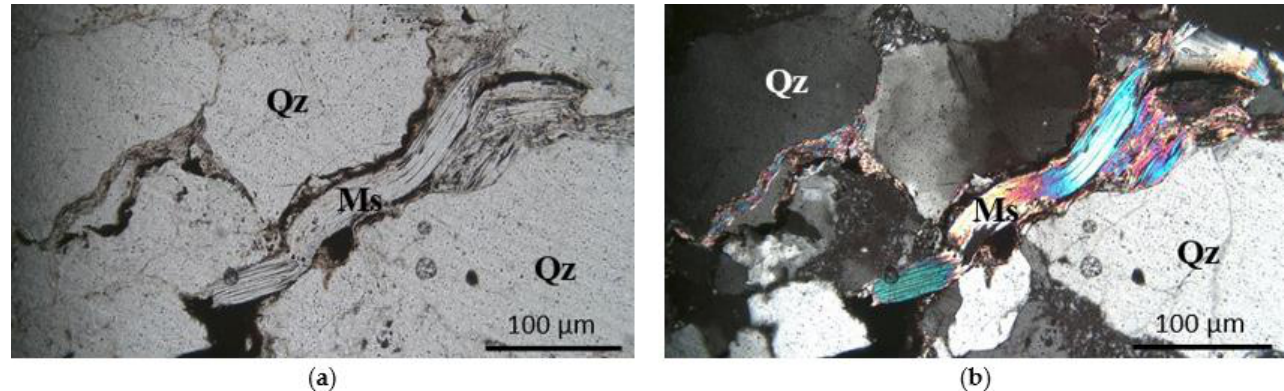
Figure 7. Wavy quenching of light on quartz grains (Qz), surrounded by clay binder: crossed polars—100× magnification.